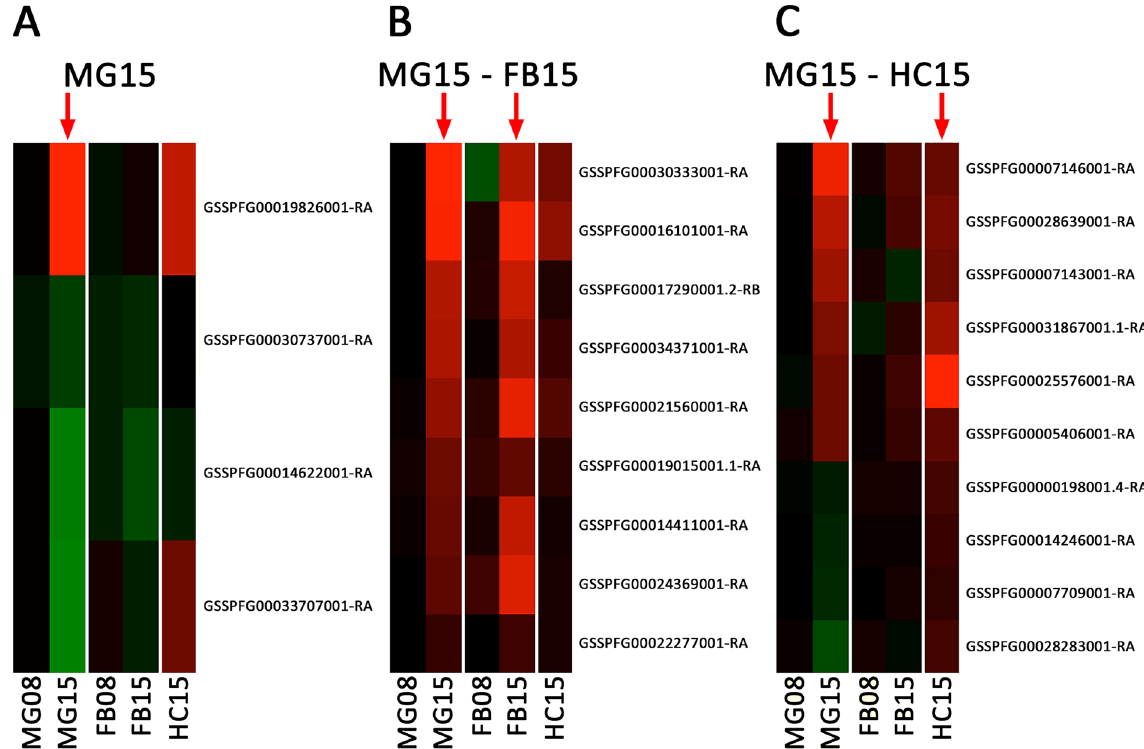
Figure 2. Midgut Associated Response. Heatmaps of differential expression (in log2FoldChange - green, under-expression, red, overexpression according to values in Supplementary Data S1) across all experimental conditions of genes found significantly differentially expressed ( A ) specifically in the MG at 15 hpi (MG15 - 4 genes) ( B ) common to MG15 and FB15 (9 genes) and ( C ) common to MG15 and HC15 (10